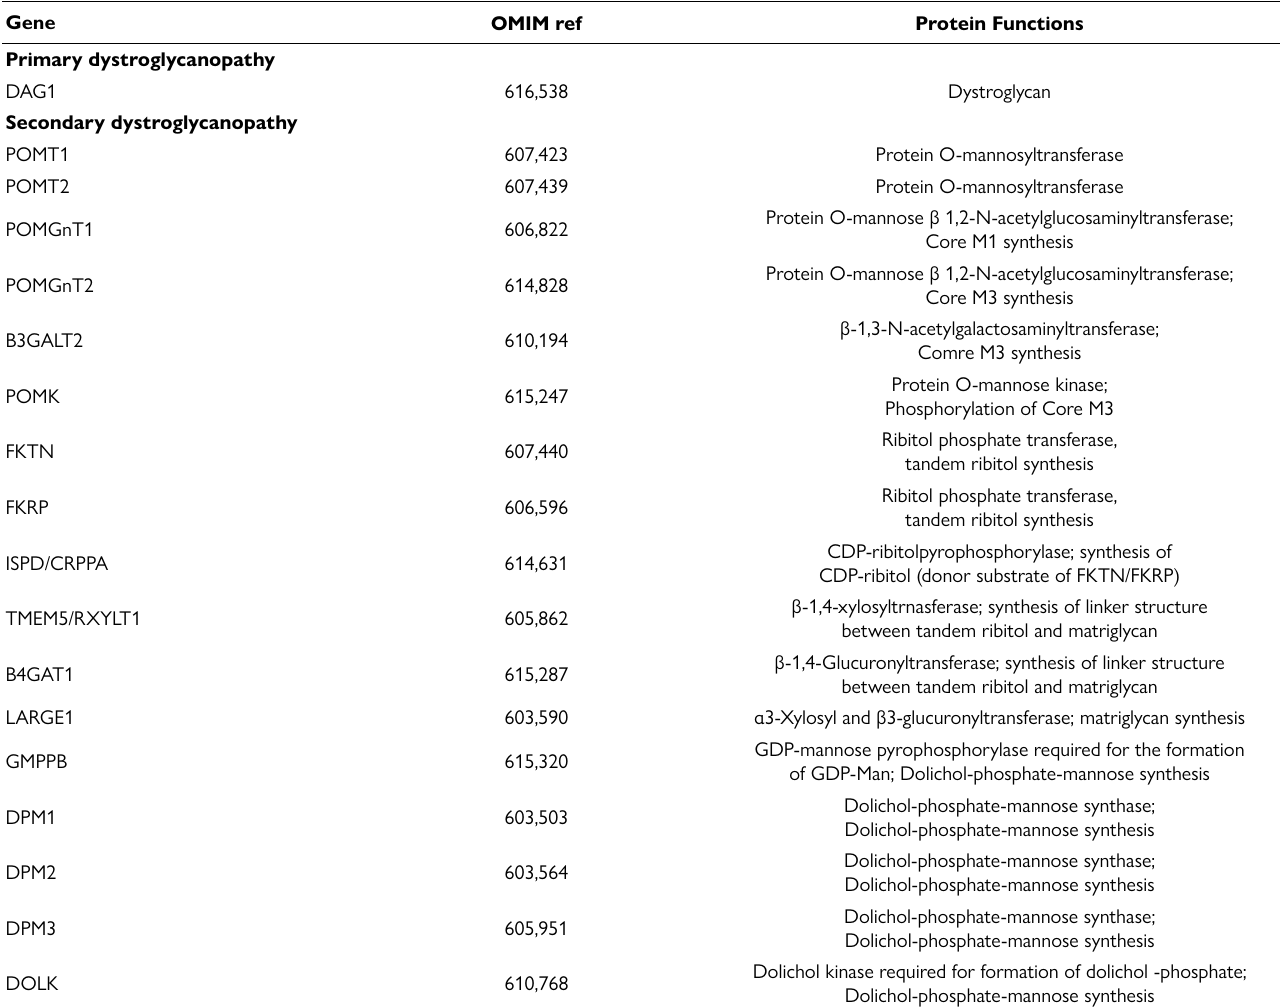
Table 2. Genes associated to